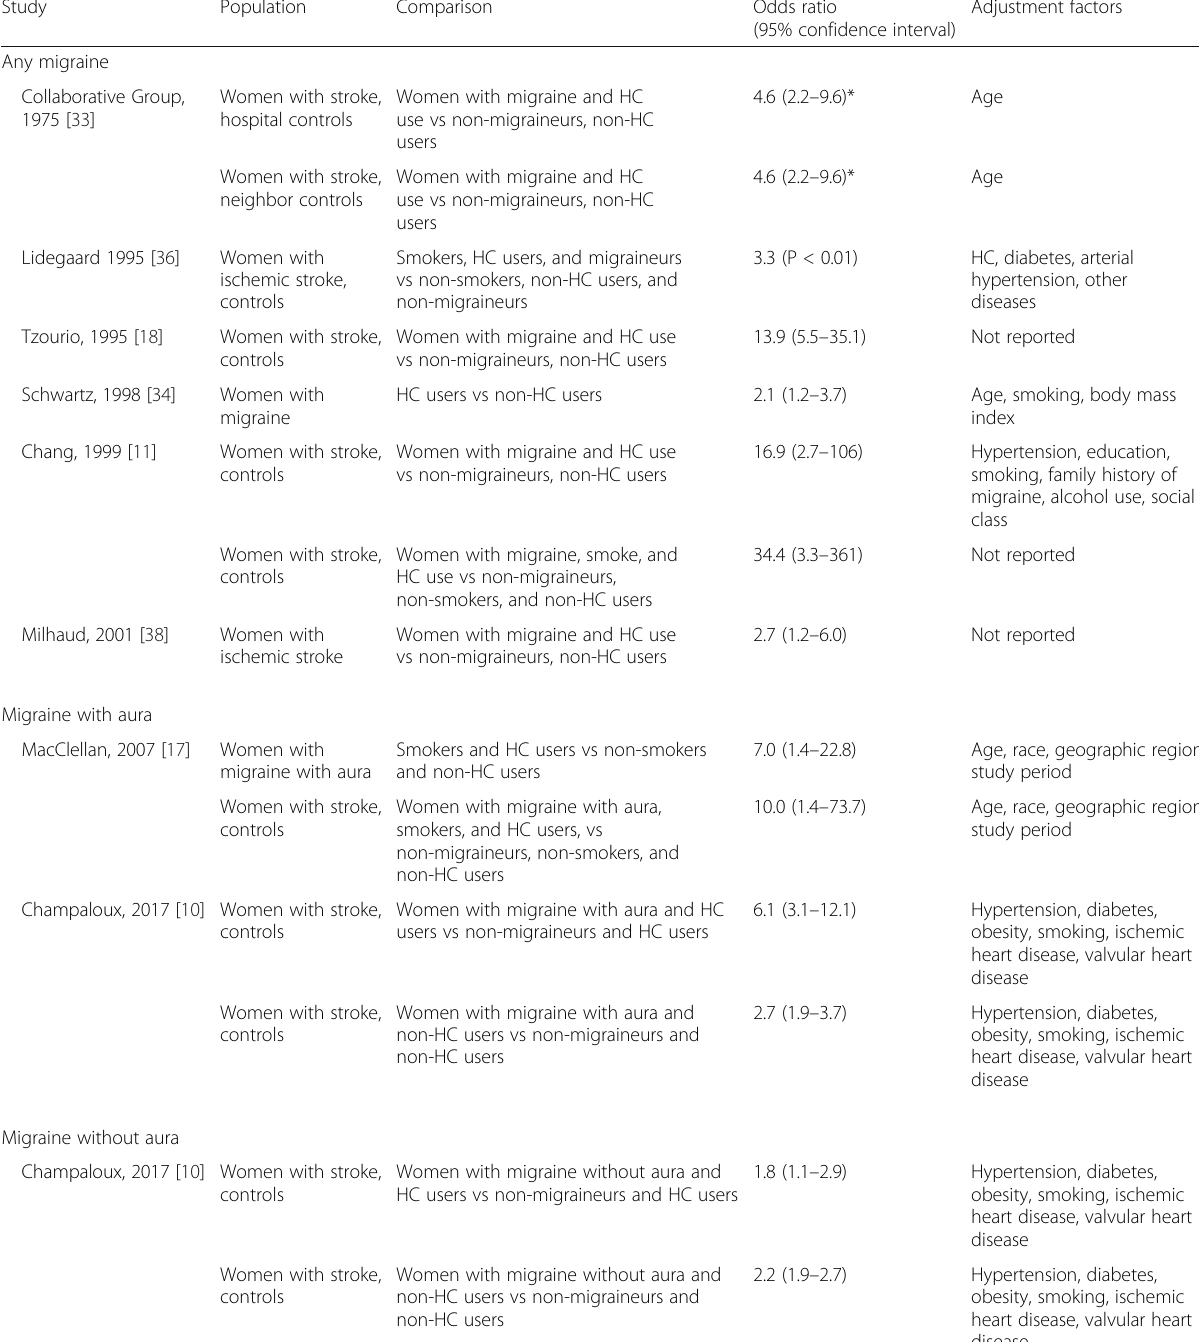
Table 3 Risk of ischemic stroke in subjects with migraine according to use of hormonal